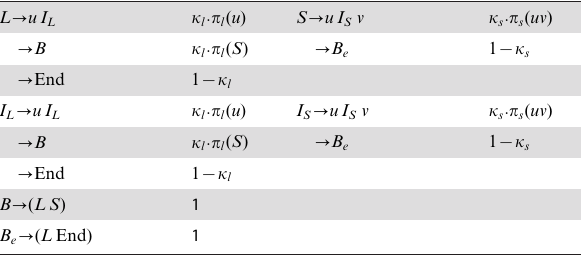
Table 2. Singlet transducer (single-sequence SCFG) of the TKF Structure Tree model.